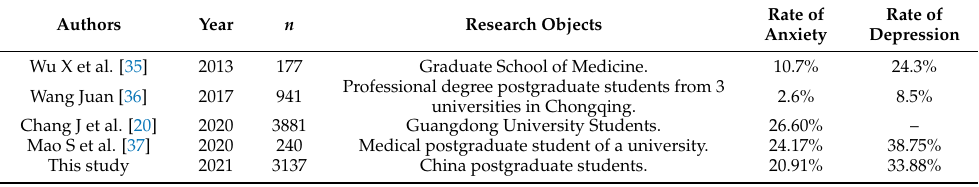
Table 2. Comparison of rates of anxiety and depression in other studies and this study.